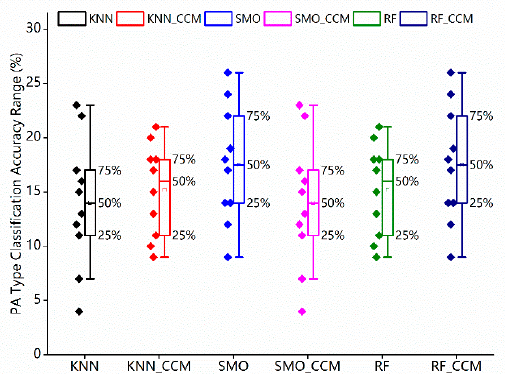
Figure 9. Statistical distributions of classification results among the equipped with CCM structure algorithm and the normal classification ones. Table 8. The classification accuracies of the 10 PA patterns comparison between the RF with CCM and the RF with non-CCM (%).